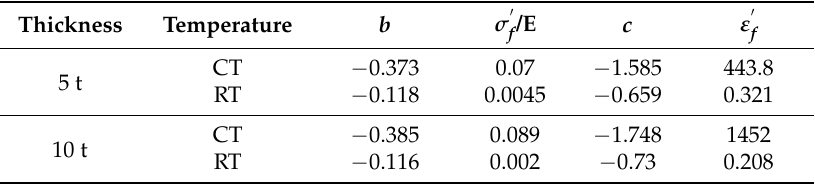
Table 6. Parameters for AISI 304L in Basquin and Coffin–Manson equation.